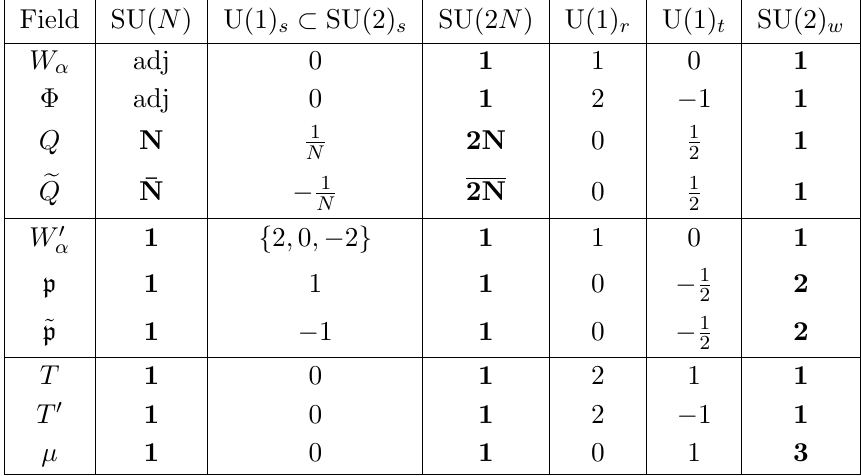
Table 1 . Supermultiplets appearing in the Lagrangian for R 0 ;N